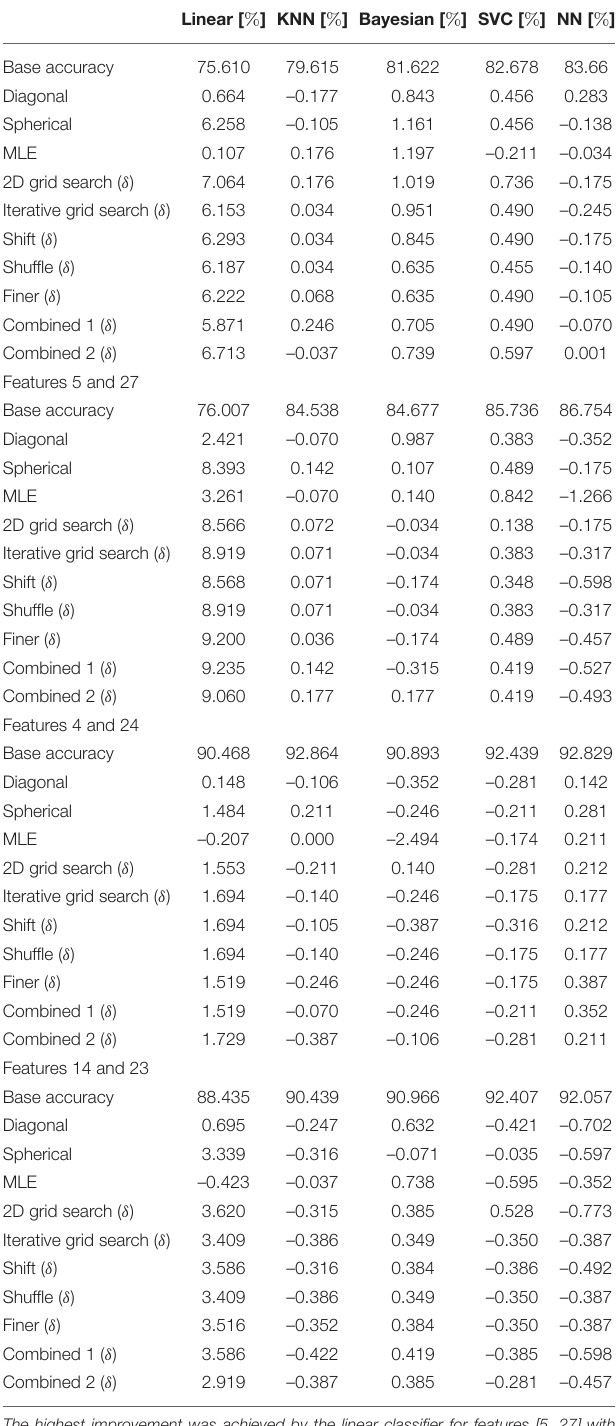
TABLE 8 | Improvement δ in accuracy for different optimization settings on 2-dimensional subsets of the breast cancer